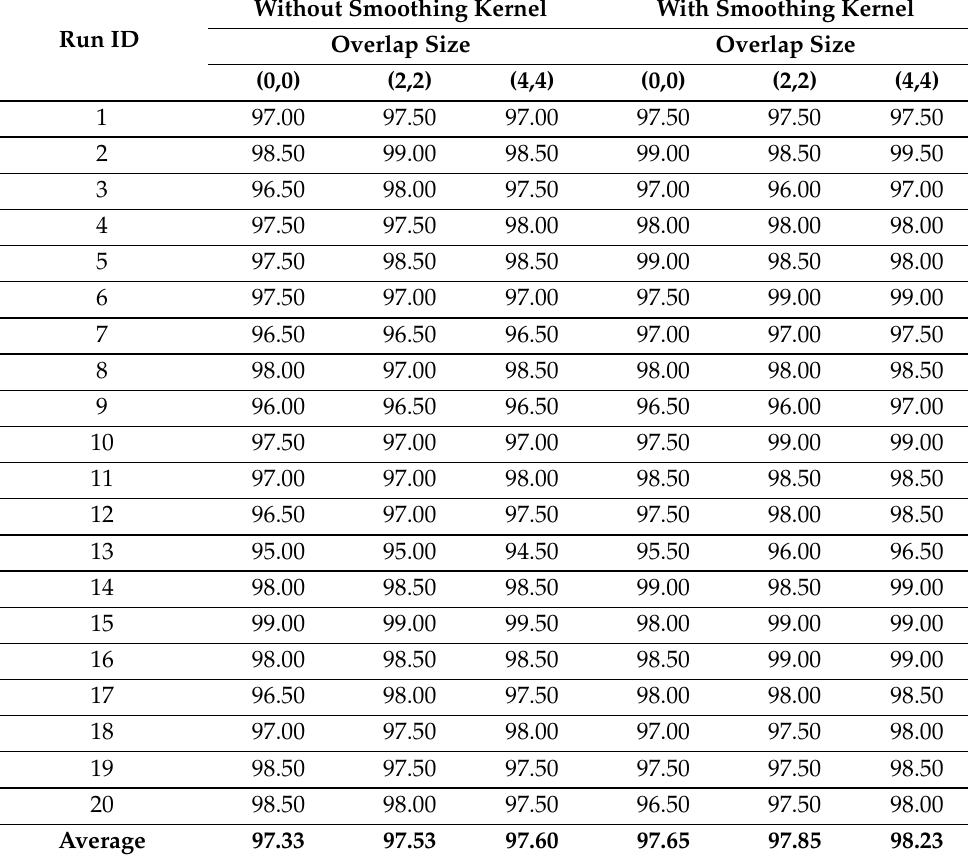
Table A7. The results of the runs for Gaussian noise with standard deviation of